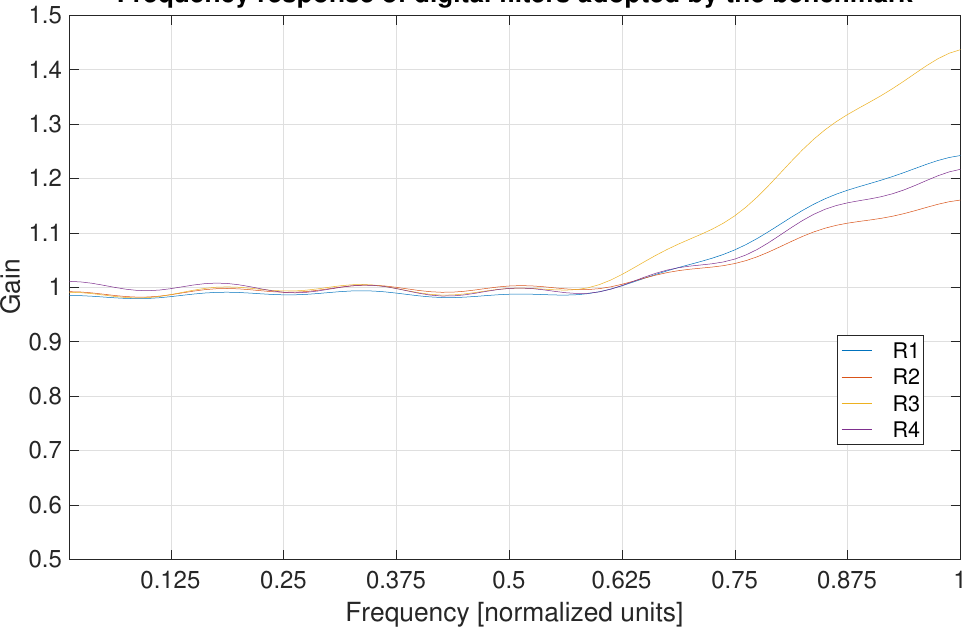
Figure 8. Frequency response of the digital filters adopted by the benchmark system to perform the equalization of the sensors. The frequency responses are evidently different from those used by the proposed method given in Figure